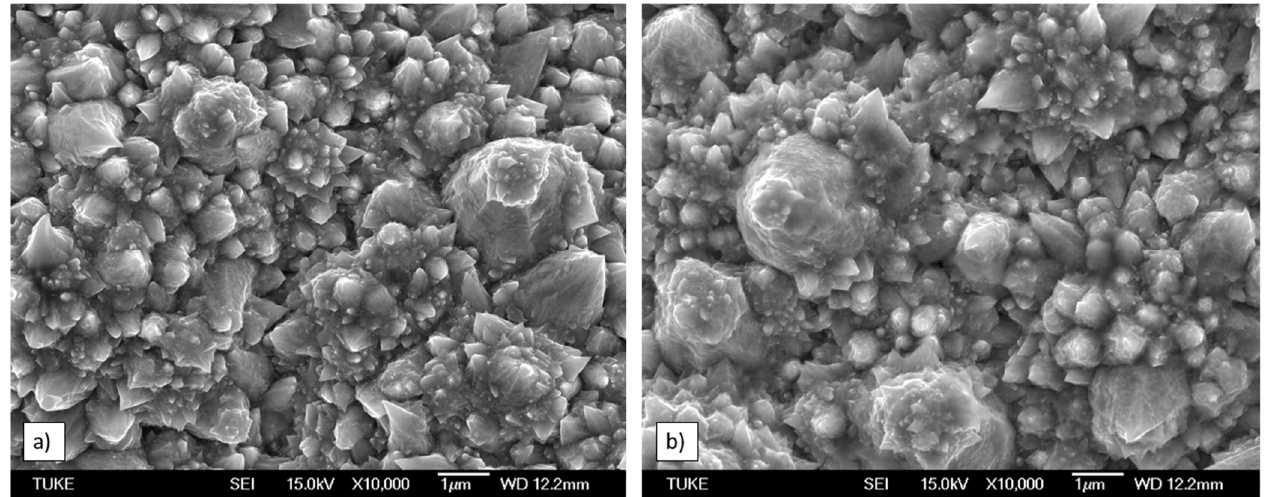
Figure 3. Surface morphology of Ni-Co coatings: ( a ) Sample 1 (with 33.32 wt. % Co deposited at 1 A dm − 2 ); ( b ) Sample 2 (with 31.80 wt. % Co deposited at 2 A dm − 2 ).